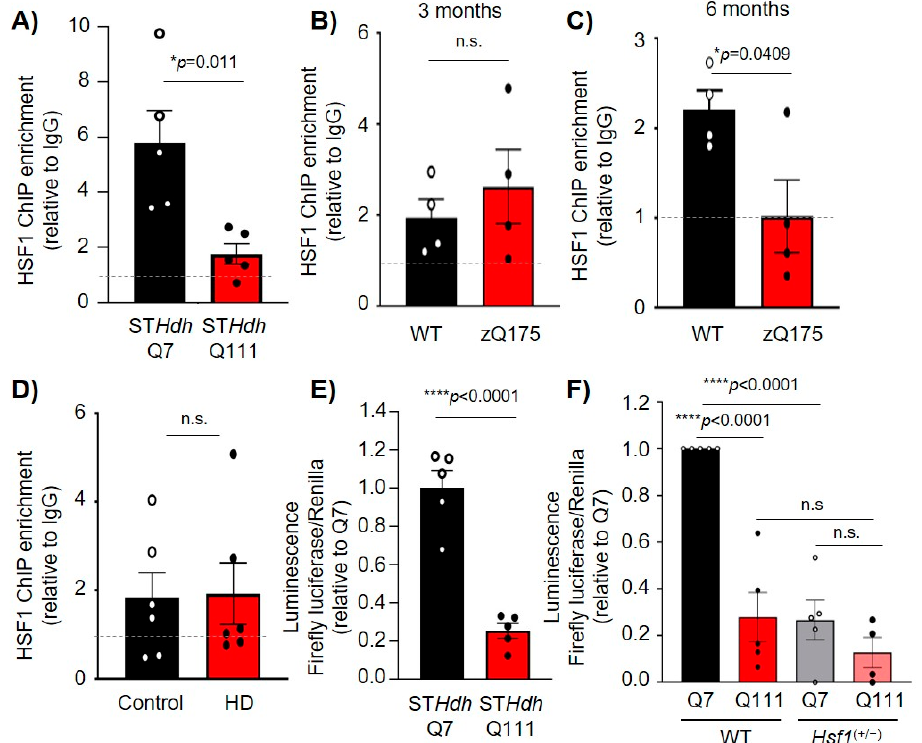
Figure 5. HSF1 binding to regulatory elements of PSD-95 and its regulation is impaired in HD. ( A – D ) HSF1-ChIP on PSD-95 HSE #3 in ( A ) ST Hdh Q7 and ST Hdh Q111 cells ( n = 6), ( B ) the striatum of